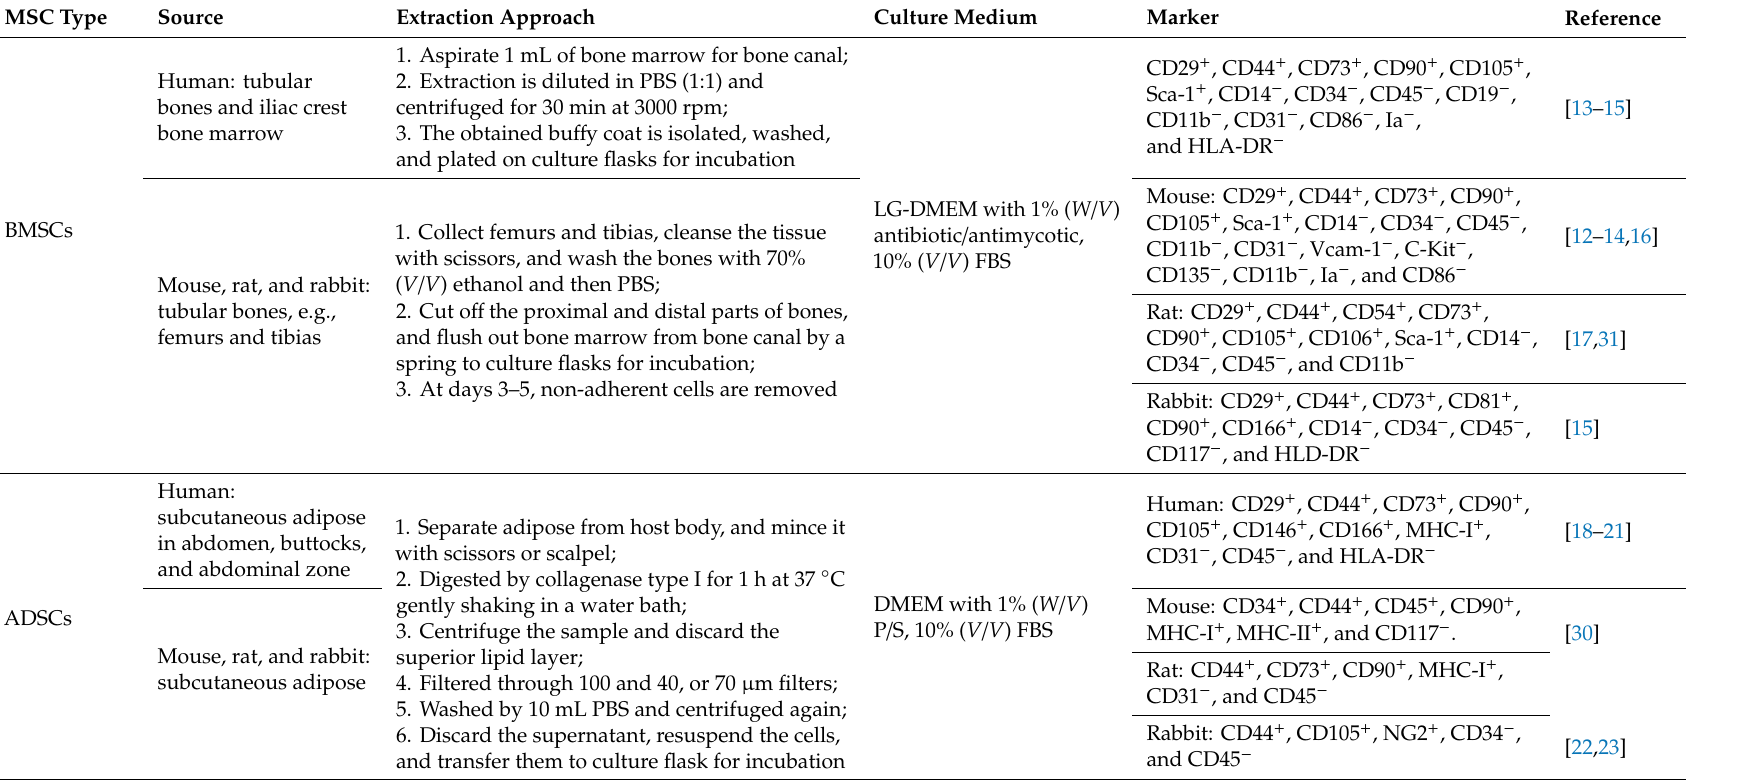
Table 1. Extraction, discrimination, and culture of MSCs derived from various